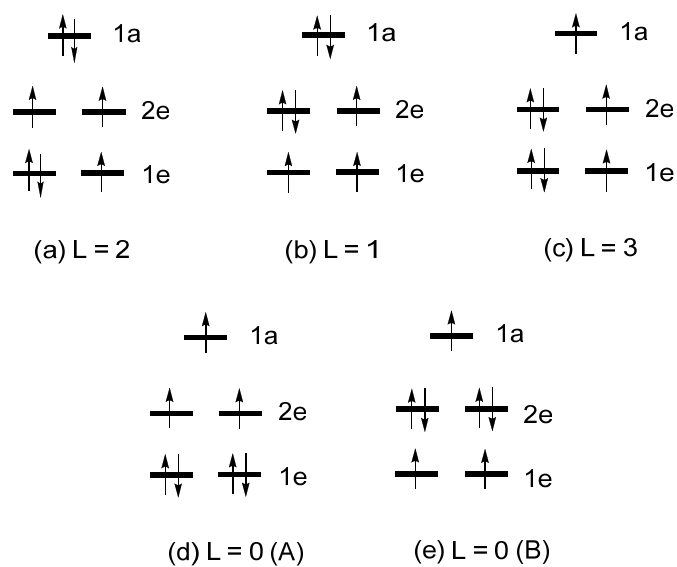
Figure 8. Five electron configurations of (Fe L 2 ) − and Co L 2 based on the d-state split pattern of 1e < 2e < 1a: ( a ) L = 2, ( b ) L = 1, ( c ) L = 3, ( d ) L = 0 (A), and ( e ) L = 0 (B) configurations. − For (Fe L 2 ) : L = 2 < L = 1 < L = 3 < L = 0 (A) < L = 0 (B) For Co L 2 : L = 2 < L = 3 < L = 0 (A) < L = 0 (B) < L = 1.